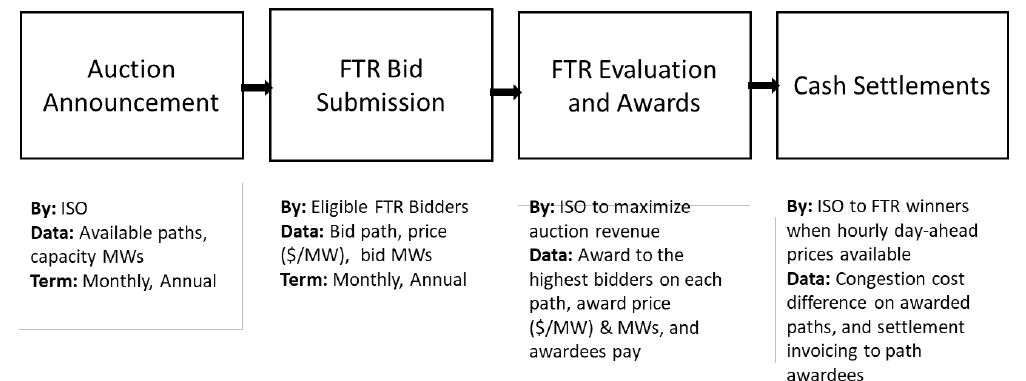
Figure 2. Financial Transmission Rights (FTR) auction flow chart.